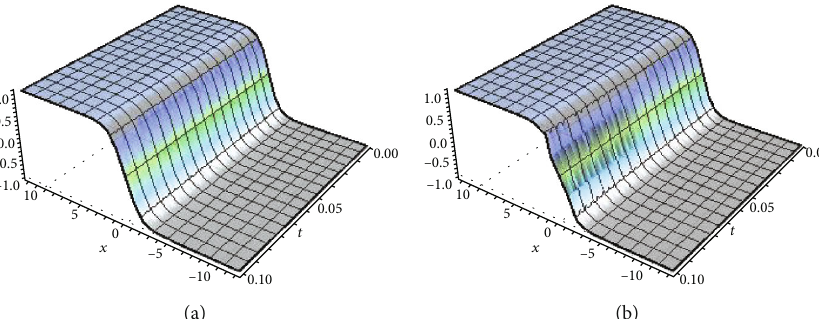
x , t Þ of FCH6 model (72) and (73) with μ = 0 : 01 for diverse α : (a) α = 0 : 75 and (b) α = 0 : 5 Figure 7: Surface wave behavior of u 3 ð